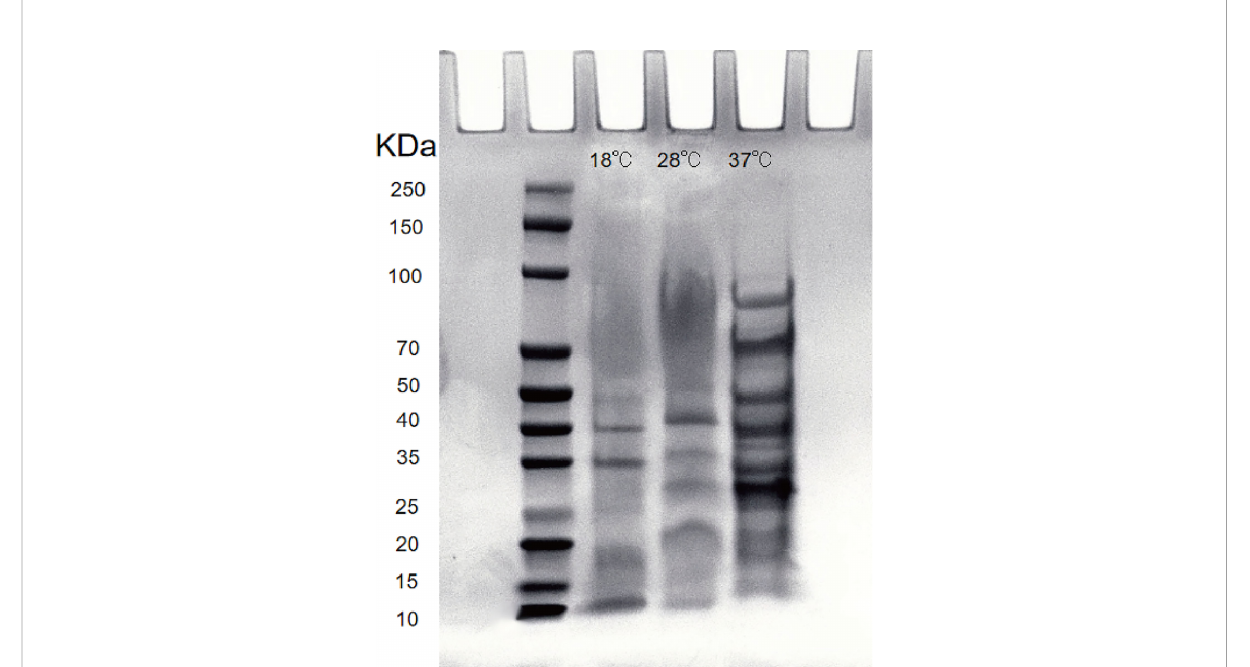
FIGURE 8 Lane 2: Protein marker; Lanel 3 - 5: Extracellular proteins of 18°C ˎ 28°C ˎ 3001;37°C, respectively; Lane 6: LB medium (negative